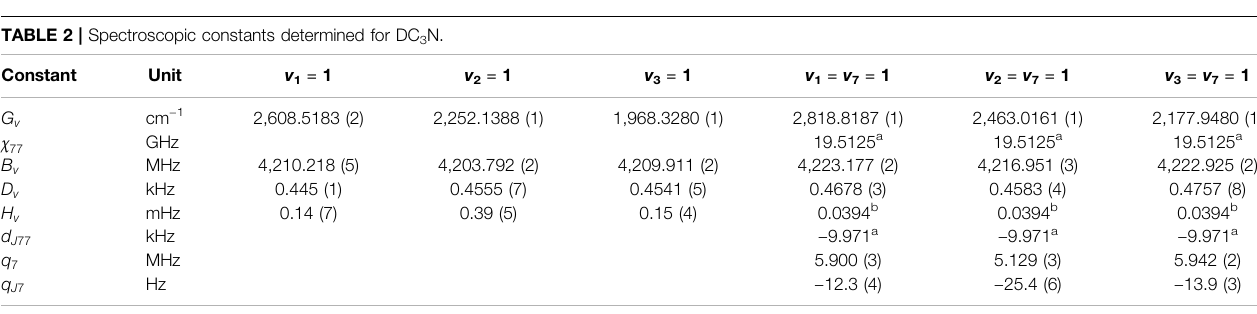
TABLE 2 | Spectroscopic constants determined for DC 3 N.